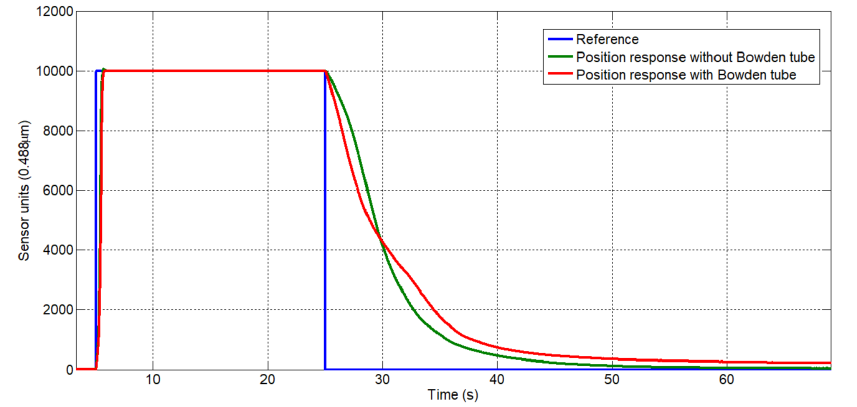
Figure 8. SMA actuator with Bowden cable vs. without Bowden cable (Figure 7